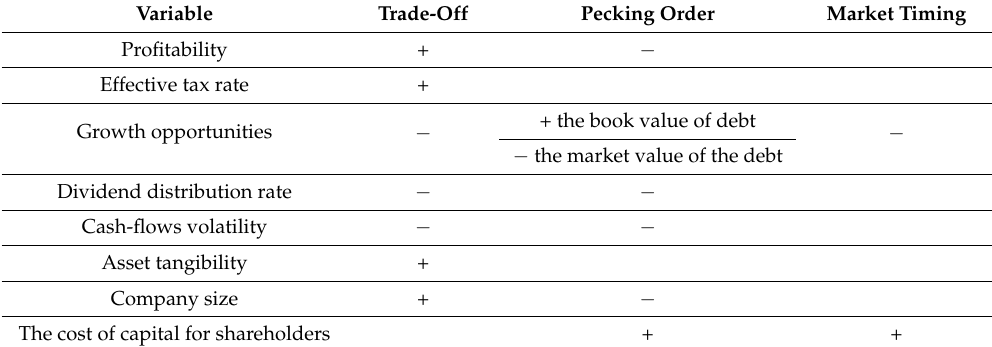
Table 1. Drivers of the capital structure and their effect according to the main theories.